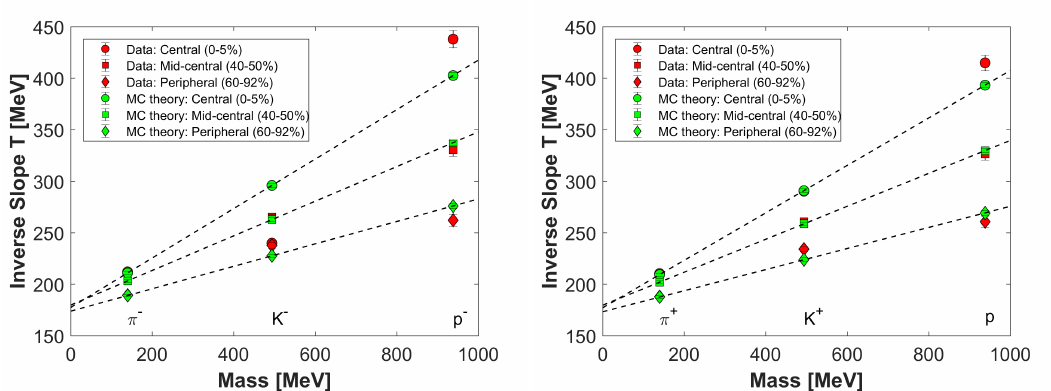
Figure 1. The mass and centrality dependence of the inverse slope parameters of positively and √ s = 200 GeV Au+Au negatively charged pions and kaons, as well as for protons and anti-protons in collisions, as measured in various centrality classes by the PHENIX collaboration, based on Figure 10 and Table IV of [2]. Dashed lines are drawn to guide the eye, corresponding to Equation (1) and also to earlier theoretical results for a single-component hadron gas in non-central heavy ion collisions as detailed in References [7,8]. Green symbols indicate our new result, based on our new exact solutions of fireball hydrodynamics for a collectively expanding and rotating, multi-component hadronic matter, as indicated by symbols with “MC theory” in the legends. These green symbols appear at discrete values of hadronic masses, corresponding to Equation (2), along the eye-guiding dashed